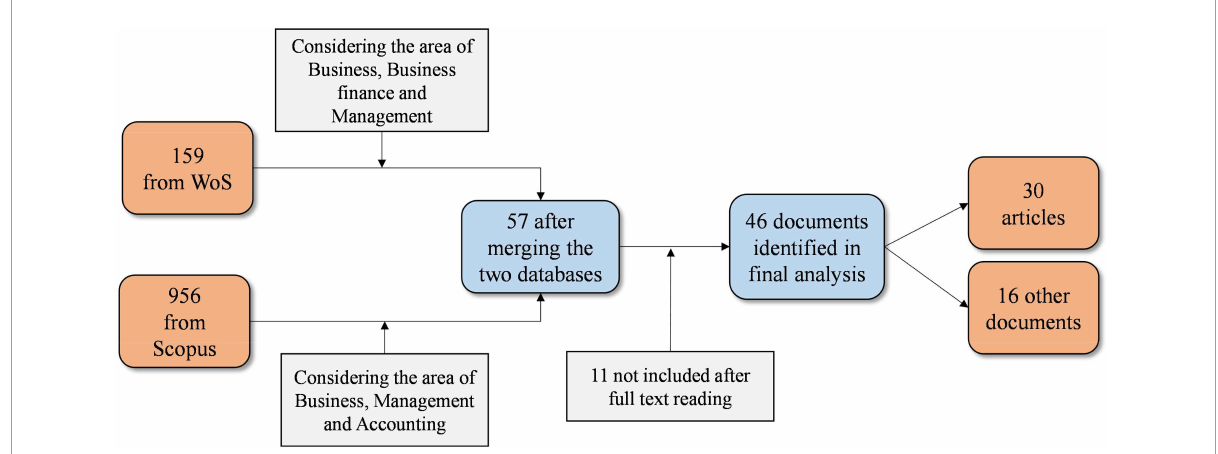
FIGURE1 Documents search and selection.